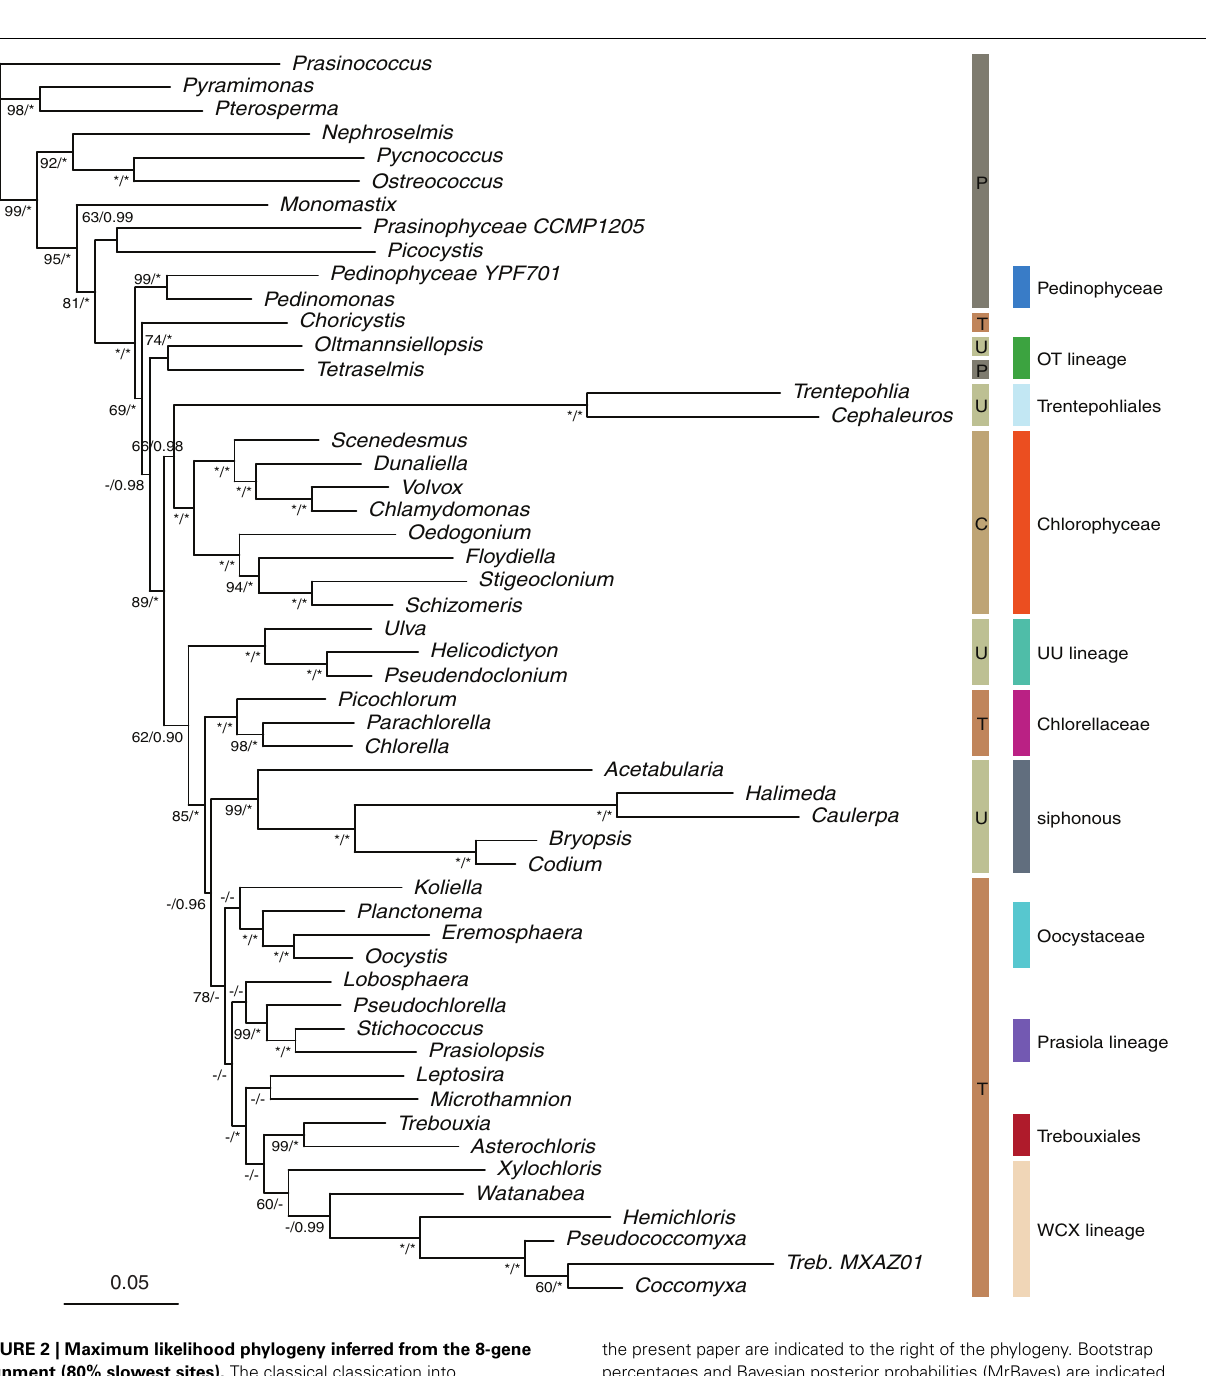
FIGURE 2 | Maximum likelihood phylogeny inferred from the 8-gene alignment (80% slowest sites). The classical classication into Prasinophyceae (P), Chlorophyceae (C), Ulvophyceae (U) and Trebouxiophyceae (T) as well as the lineage-based classication discussed in